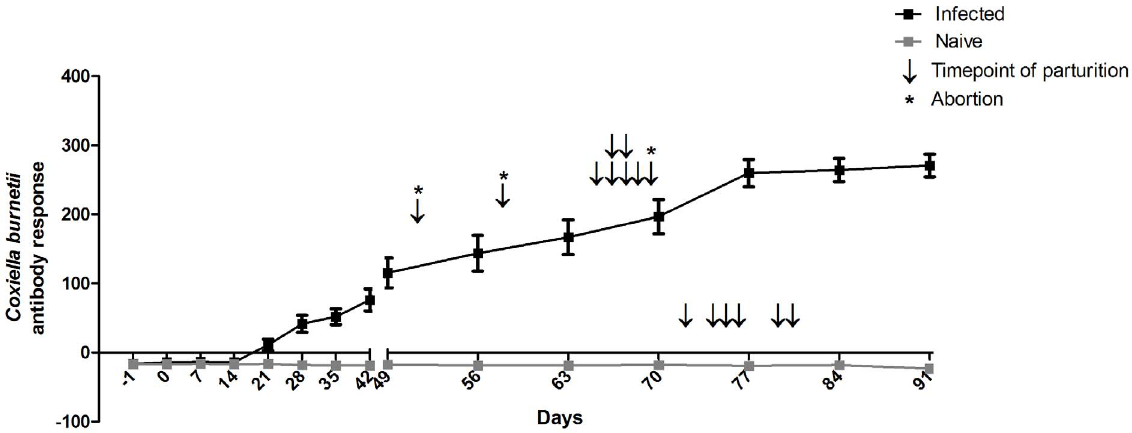
Figure 1. Successful experimental infection of goats with Coxiellaburnetii 3262. Eleven out of seventeen goats were intranasally infected with C. burnetii 3262. The remaining six were kept naive. During the infection, antibodies against C. burnetii were measured weekly in the serum of all goats using the LSIVET RUMINANT milk/serum Q-fever ELISA kit. Grey squares represent naive goats, black squares represent infected goats. Median values with SEM are shown. Parturition is indicated for each individual goat using an arrow. Abortion, defined as birth of dead lambs, is indicated with an asterisk. The final two remaining pregnant infected goats were culled for other purposes, and therefore not included in this graph.